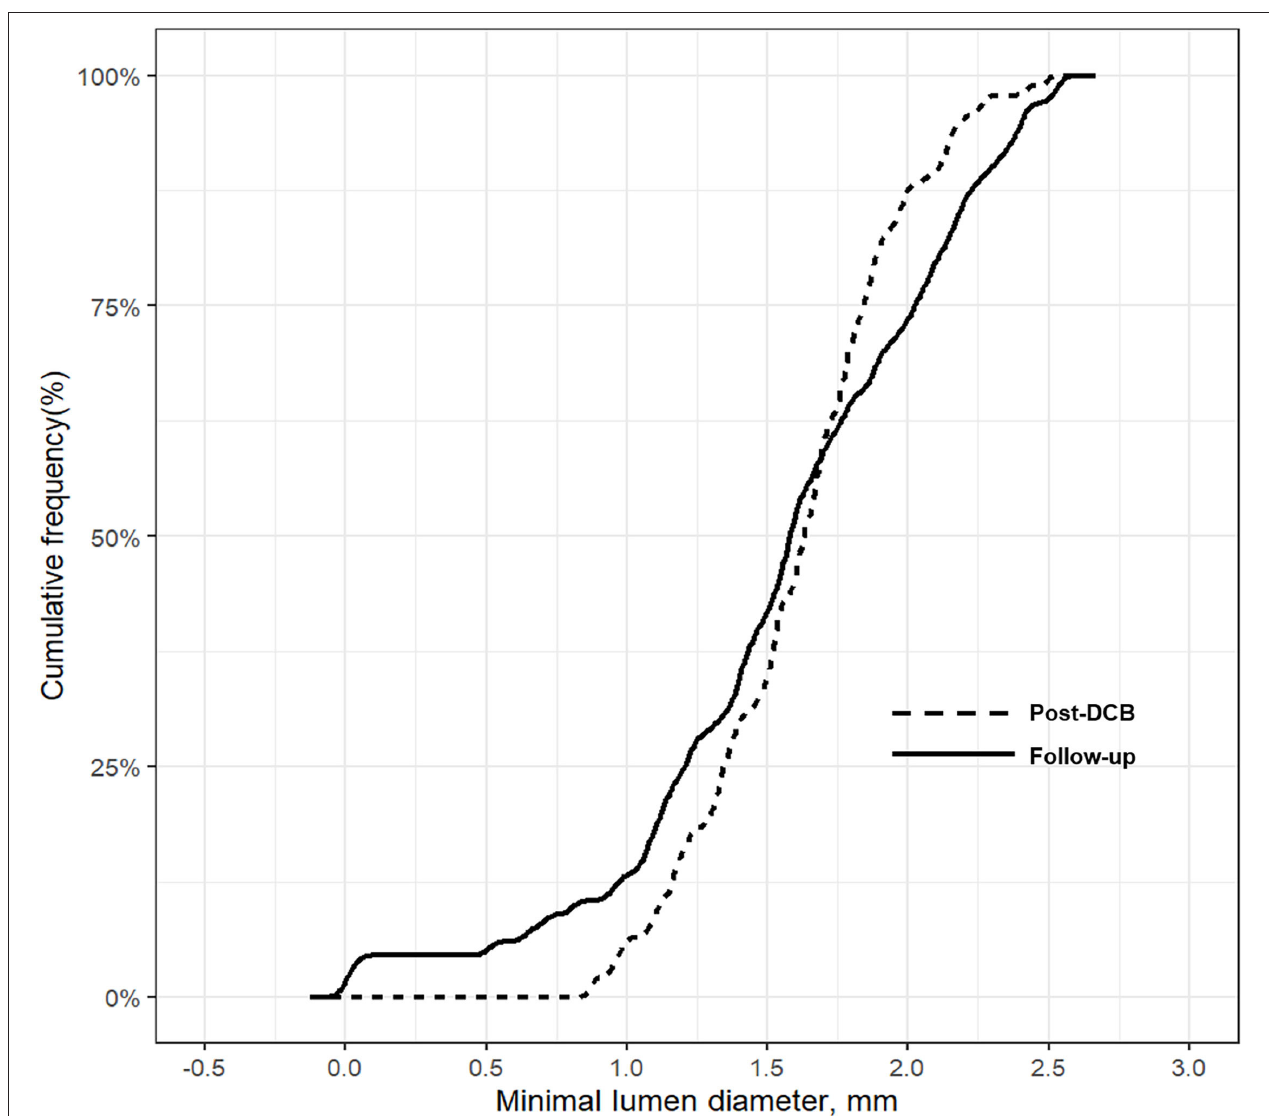
FIGURE 3 | Cumulative frequency distribution of MLD. MLD, minimal lumen diameter.